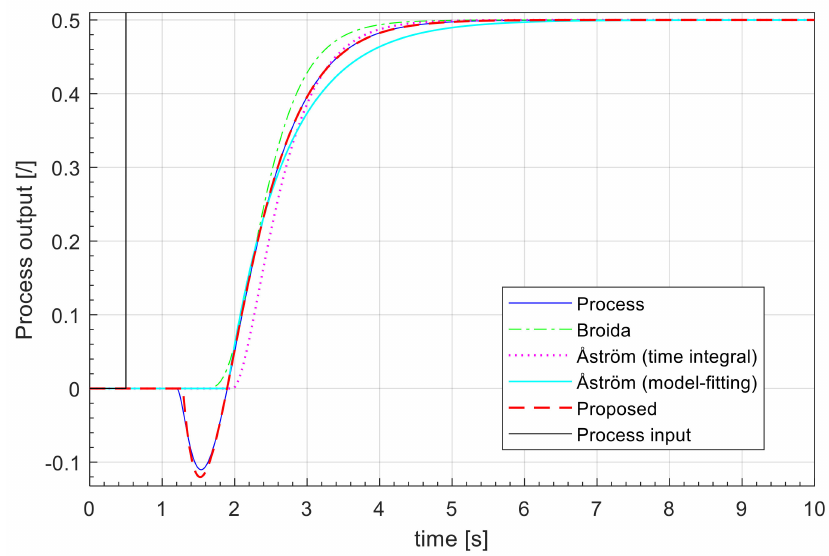
Figure 13. The step-change responses for process G P3 .